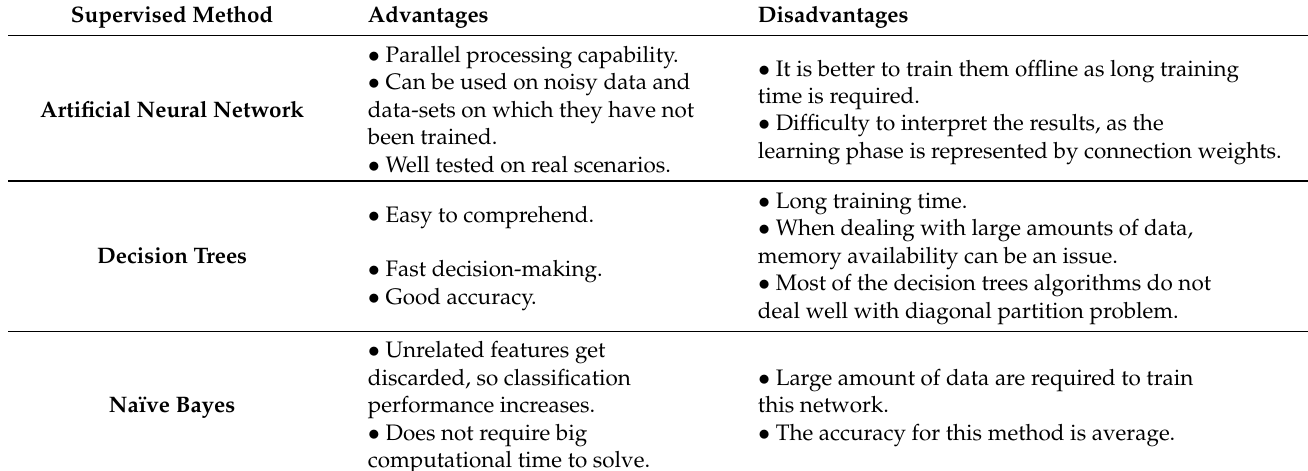
Table 1. Supervised methods in ML